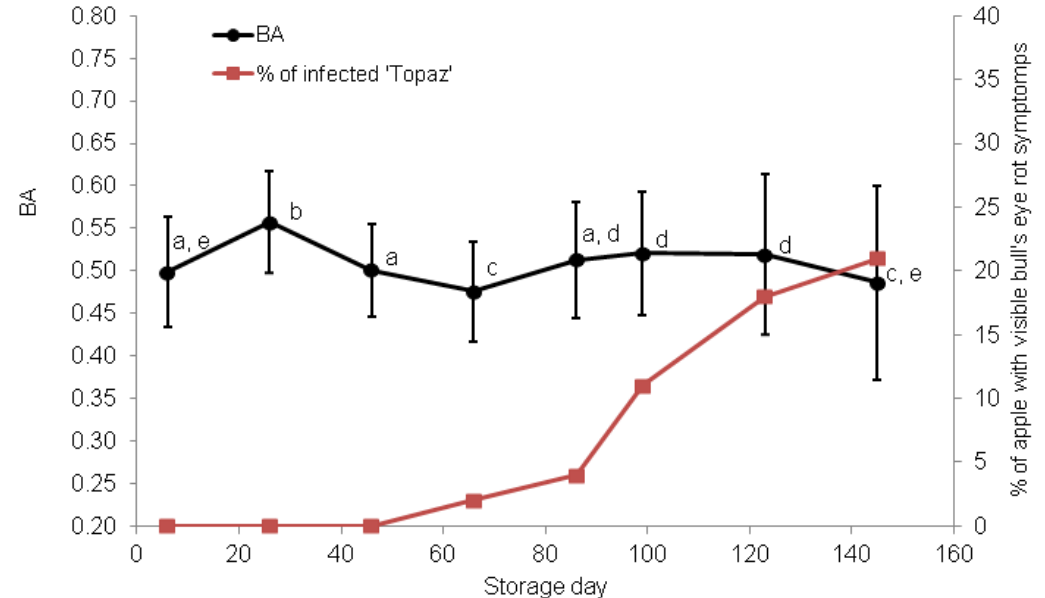
Figure 3. Biospeckle activity BA (black line) and percentage of infected fruit (red line) during development of bull’s eye rot of ‘Topaz’ apples. Bars indicate standard deviation; different letters denote significant differences (at α = 0.05) between